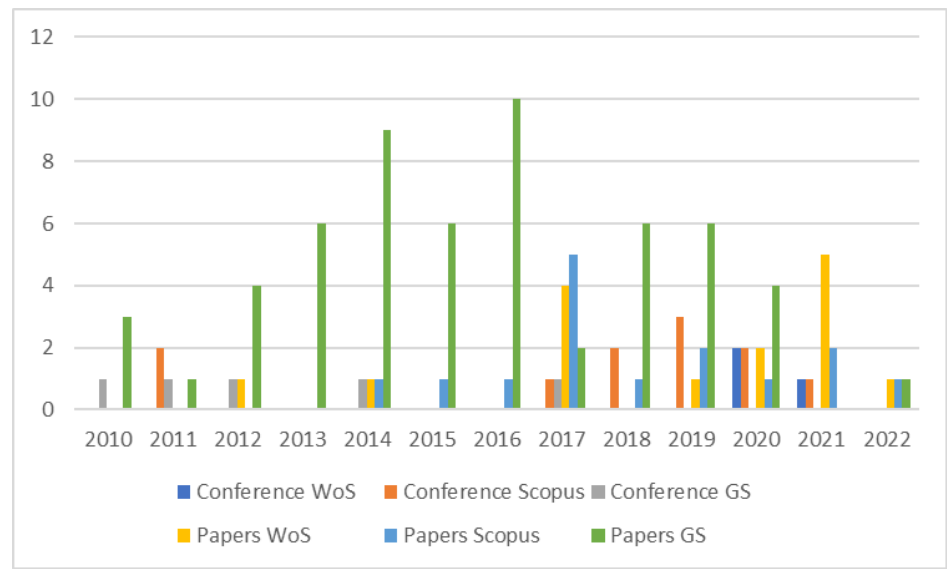
Figure 11. Frequency of published studies in the databases over the study period. Source: own pro- cessing.